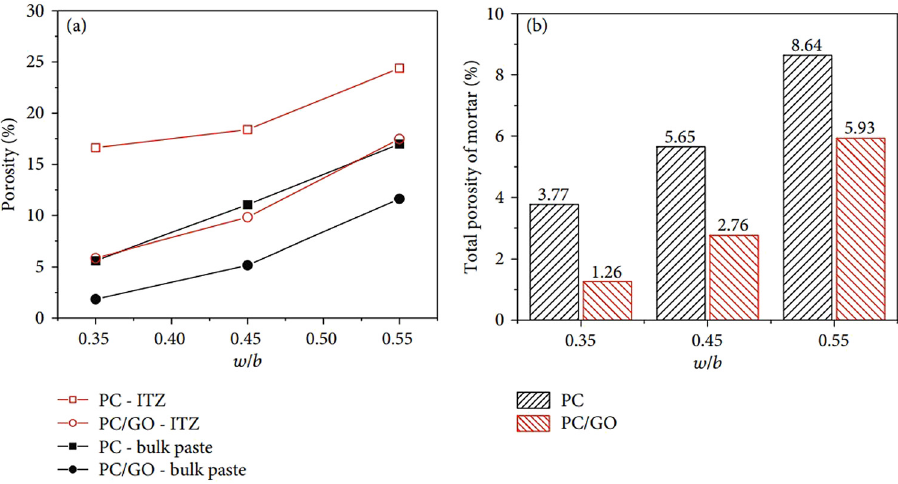
Figure 10: Porosity in specimen control specimen ( PC ) and specimen with GO ( PC/GO ) at varied w/b: ( a ) porosity in ITZ and bulk paste; ( b ) porosity in the whole mortar [ 116 ] .